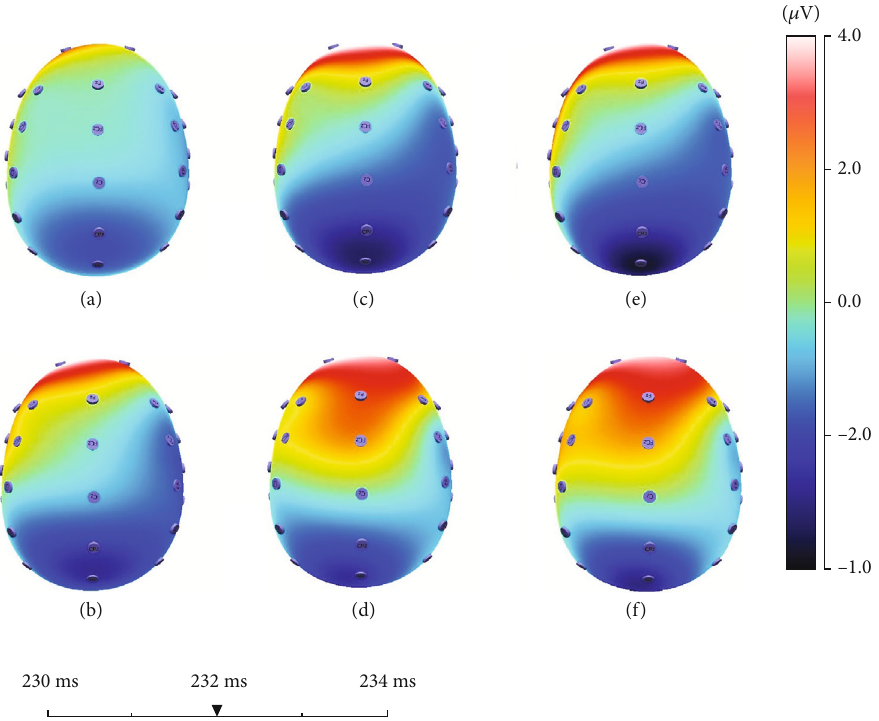
Figure 6: The e ff ects of losses and gains on the EEG in the whole regions of the brain when the outcomes appeared after 232 ms. The red region tends to show obviously the characteristics of positive-polarity ERP, and the blue region tends to show negative-polarity ERP. (a, c, and e) Represent the losses; (b, d, and f) show the gains. (a, b) indicate that E = 5 ; (c, d) mean that E = 7 ; (e, f) show that E = 10